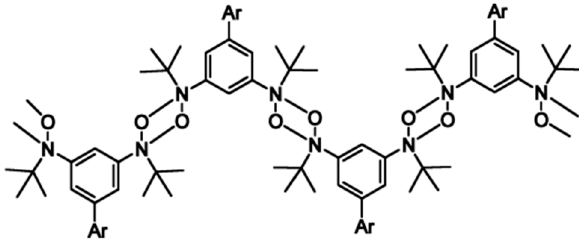
Figure 2. Schematic drawing of the chain involving intermolecular N···O bonds.